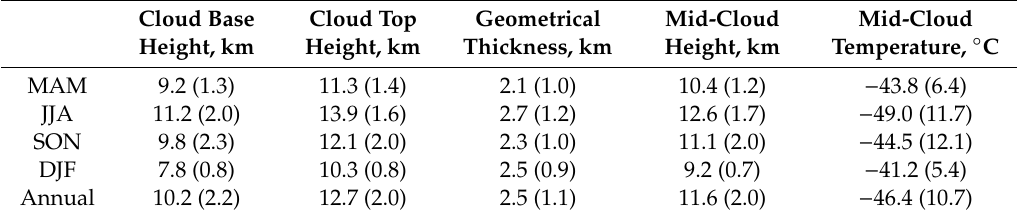
Table 1. Mean values and standard deviations (in parentheses) of cirrus geometrical properties and corresponding temperatures from seasonal and annual statistics.